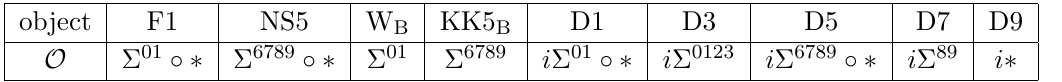
Table 4 . The different operators O appearing in the SUSY projector defined in (B.3) for the various fundamental BPS objects of type IIB string theory. We introduced the notation Σ i 1 ...i 2 p ≡ Σ [ i 1 · · · Σ i 2 p ] , while ∗ denotes complex conjugation. All objects are assumed to fill the first ( p + 1) spacetime